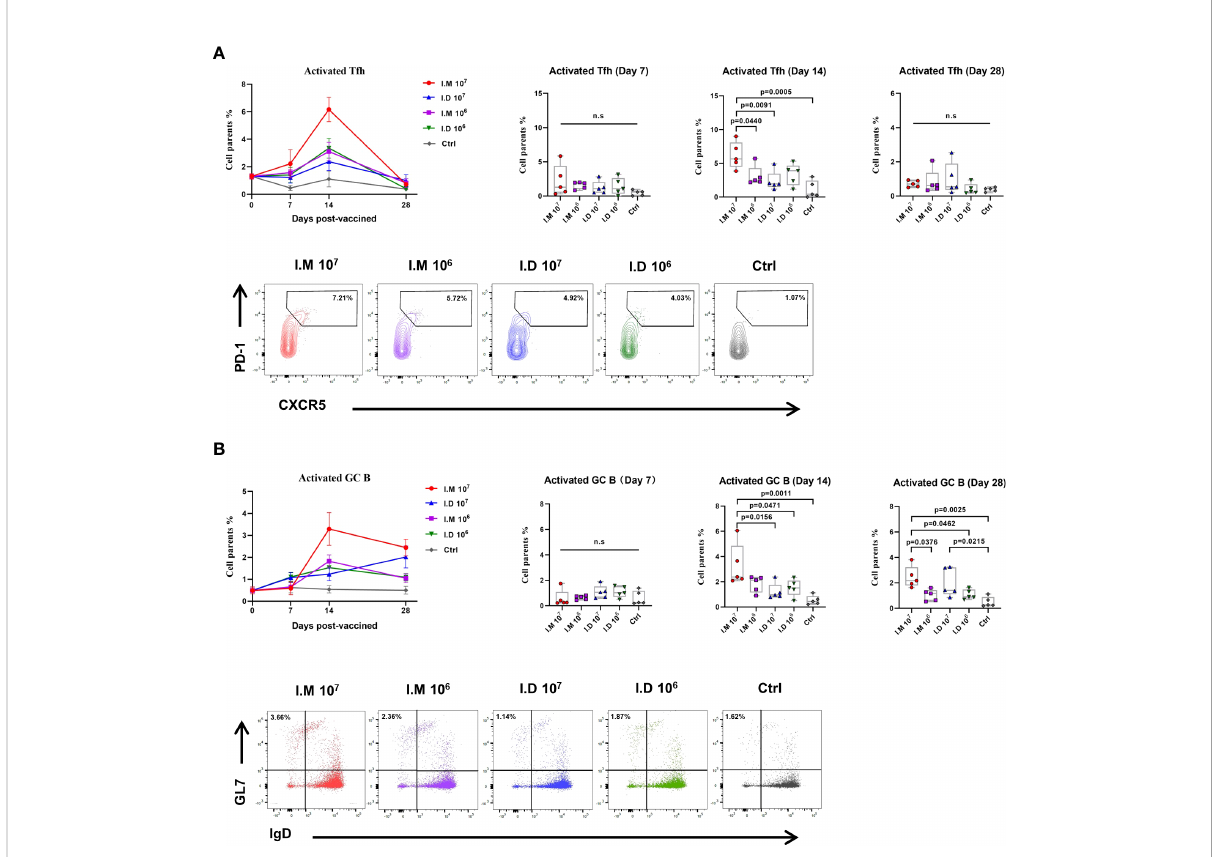
FIGURE 3 Intramuscular and intradermal injections elicited similar Tfh and GC B cell responses but induced different levels of response. Inguinal and popliteal lymph nodes were sampled at indicated times following immunization to measure the Tfh and GC B response. (A) CD3+CD4+PD1 +CXCR5+ Tfh was determined and compared in mice injected with Ad5-EBOV in different doses and routes. (B) CD4+B220+GL7+IgD- GCB was determined and compared in mice injected with Ad5-EBOV in different doses and routes. Data is represented as median with 95% CI. Statistical signi fi cance was determined using one-way ANOVA followed by Tukey's multiple comparisons test. n.s indicated no signi fi